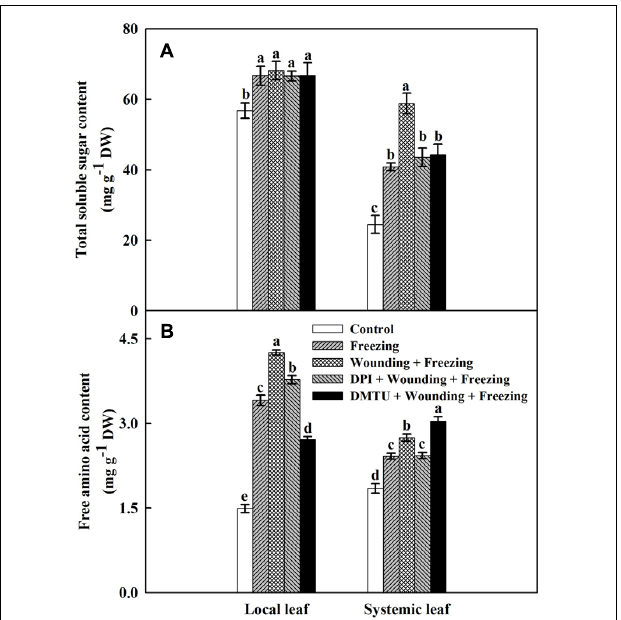
FIGURE 8 | Effects of mechanical wounding on contents of total soluble sugars and free amino acids in the local and the systemic leaves of wheat under freezing stress. Total soluble sugars content expressed in mg g − 1 DW (dry weight) (A) and free amino acids content expressed in mg g − 1 DW (B) . The local (fifth) leaves were separately pre-treated with distilled water, 5 mM DMTU or 100 µ M DPI prior to wounding. At 10 days after wounding, the seedlings were exposed to freezing stress for 24 h. After 24 h recovery, both local and systemic (sixth) leaves were collected and contents of total soluble sugars and free amino acids were determined. Data are mean values ± SD for three independent replicates. Means denoted by different letters indicated significant difference at P < 0.05 according to Tukey’s